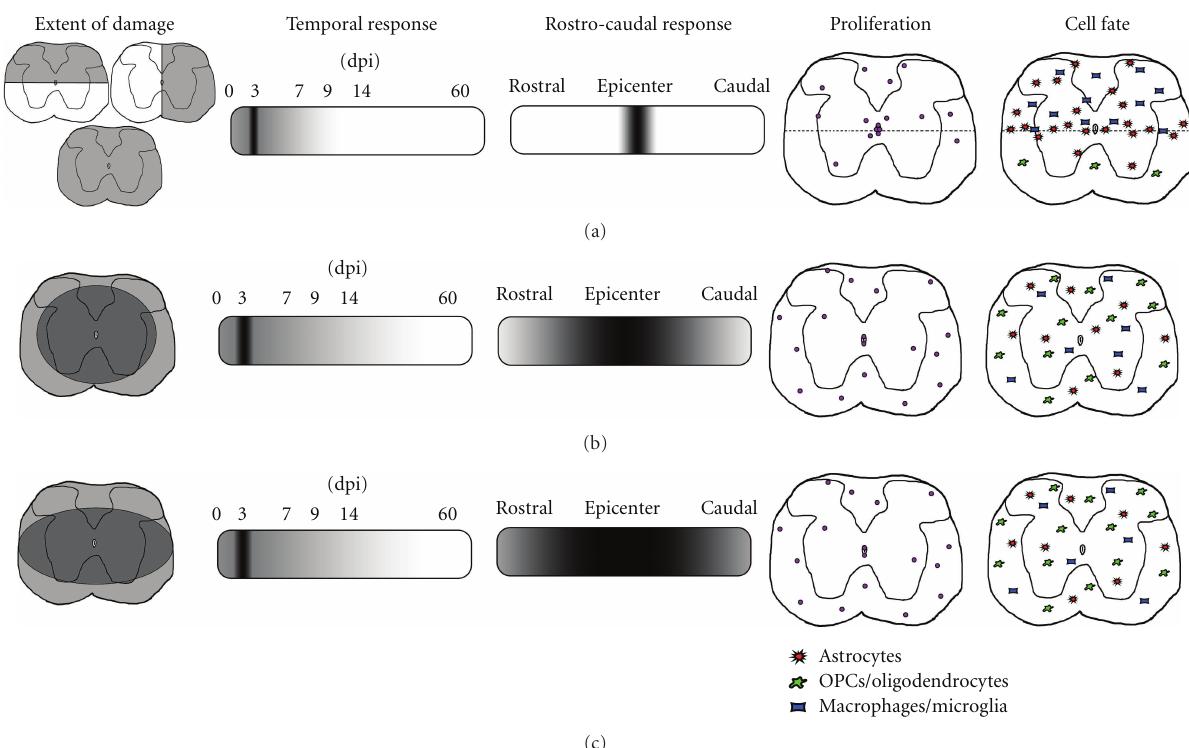
Figure 1: Qualitative summary of the features of the three types of animal models of SCI. Diagrams were created based on the references listed in Table 1. (a) Examples of transection injuries include dorsal hemisections (left), lateral hemisections (right), and complete transection (bottom). Proliferation peaks at 3dpi and tapers o ff by 9dpi. The mitotic response to injury is localized to the epicenter. Transection injuries are characterized by daughter cells acquiring astrocyte and macrophage/microglia fates. These cell types migrate to the region of injury. Depicted in the two right-most diagrams is proliferation and cell fate preferences in a dorsal hemisection injury. (b) A contusion injury typically results in a rim of spared white tissue. In response to injury, proliferation peaks at 3 dpi and is elevated for 14 days. Contusion injuries are characterized by a proliferative response that spans the rostrocaudal extent of the spinal cord. Cell fate of mitotic cells trends towards the oligodendrocyte lineage, but astrocytes and microglia also represent a portion of dividing cells. (c) Compression injuries closely resemble contusion injuries both in the extent of the spinal cord a ff ected and cell types